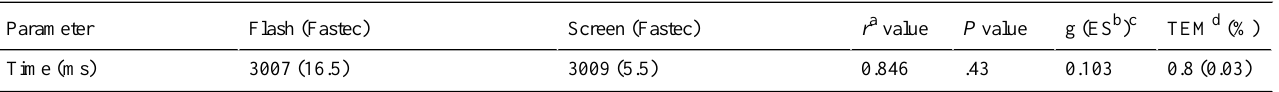
Table 3. Mean and standard deviation for the comparison between values of the flash opening time and values obtained by the repeated measurements test using the TReaction app and the measures of the color change in the computer screen